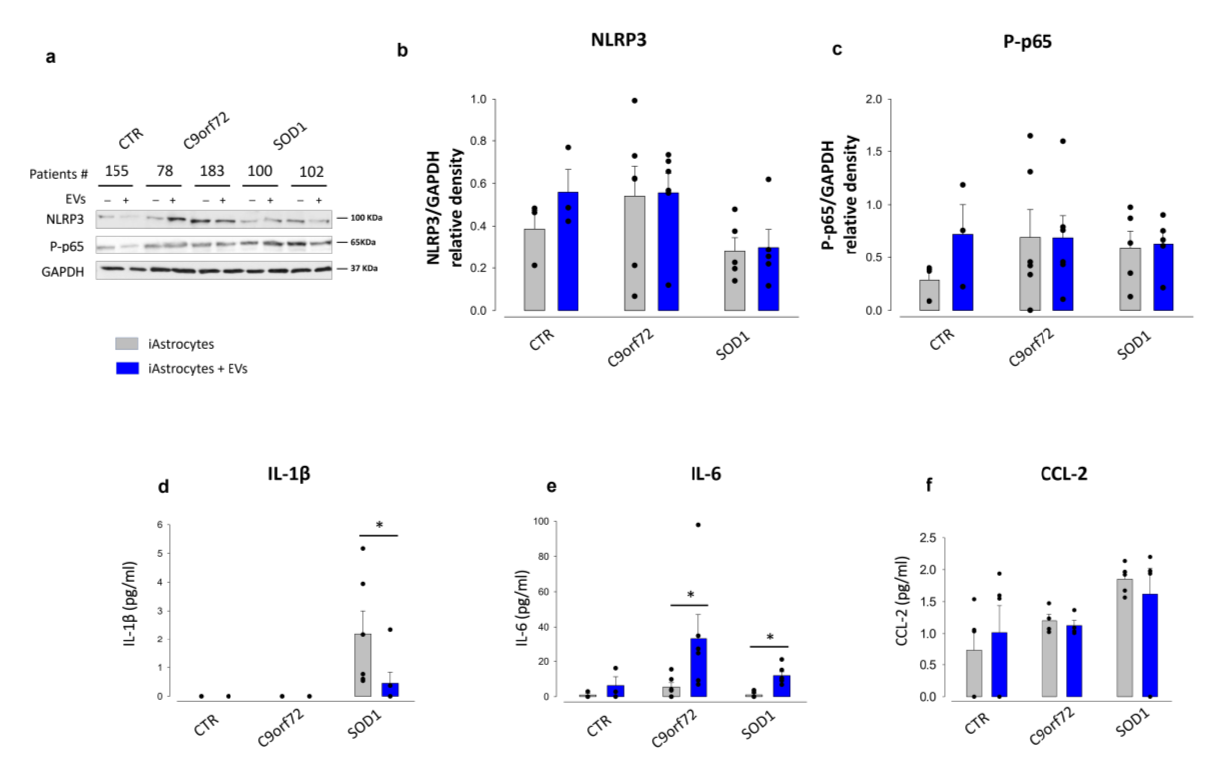
Figure 4. MSC-derived EVs do not affect the NLRP3-inflammasome, nor the p65 pathway in patients- derived iAstrocytes. ( a ). Representative WB immunoreactive bands for NLRP3 and P-p65 in patient- derived iAstrocytes differentiated from control (CTR) subjects, C9orf72, and SOD1 patients treated or not 24 h with human MSC-derived EVs. ( b , c ) Quantitative representation of WB densitometric expression signals for ( b ) NLRP3 and ( c ) P-p65 normalized to GAPDH. EV treatments did not show any significant effect on protein expression. Data are presented as means ± SEM of n = 3 independent experiments per patient. One control and 2 patients per group are included (One-way ANOVA, followed by Bonferroni post hoc test). ( d – f ) ELISA quantification of cytokines, reported as pg/mL, for ( d ) IL-1 β , ( e ) IL-6 and ( f ) CCL2, in the conditioned media of iAstrocytes differentiated from control CTR, C9orf72, and SOD1 subjects treated or not 24 h with human MSC-derived EVs. Data are presented as means ± SEM of independent experiments as follows: n = 3–6 for one CTR, n = 4–6 for 2 C9 donors and n = 5–6 for 2 SOD1 donors; statistical significance for p < 0.05 at least (* p < 0.05 vs. untreated iAstrocytes; F (2,30) = 8.936, F (2,24) = 2.833, F (2,30) = 2.677, for IL-1 β , IL6 and CCL2, respectively, in untreated vs. EV-treated iAstrocytes; two-way ANOVA with Sidak’s multi comparison